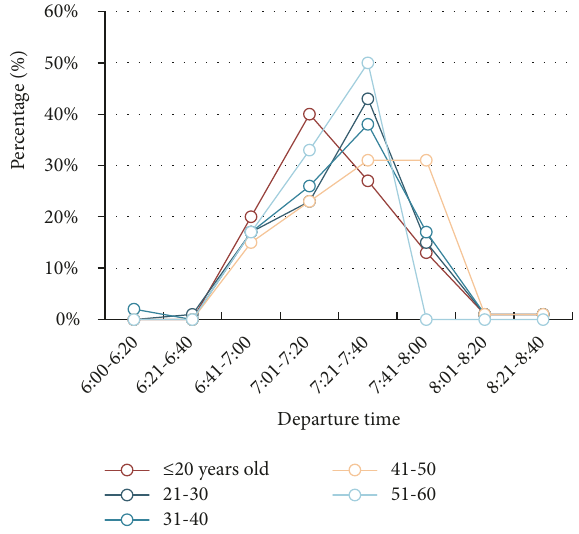
Figure 4: Departure time preferenceof commutersat different